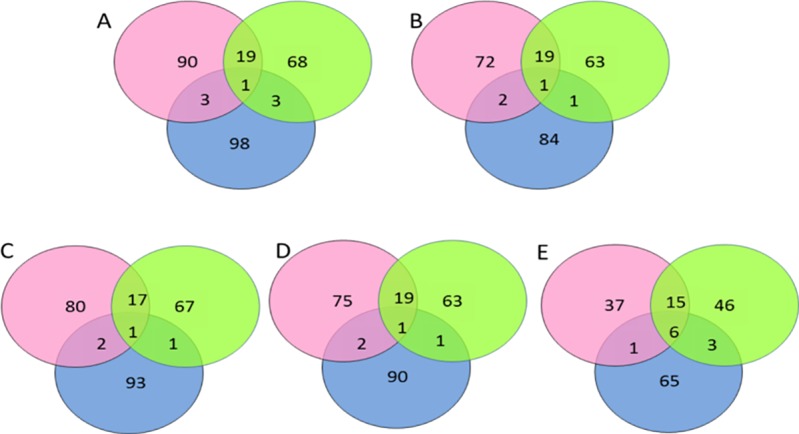
Venn diagram of shared MOTUs among the three oceans: Arctic (pink), Atlantic (green) and Pacific (blue).The number of MOTUs in each group and shared between groups is indicated. A: MOTUs were defined with a 3% threshold. B: MOTUs were defined with a 16% threshold. C: MOTUs were defined with a 4% threshold.